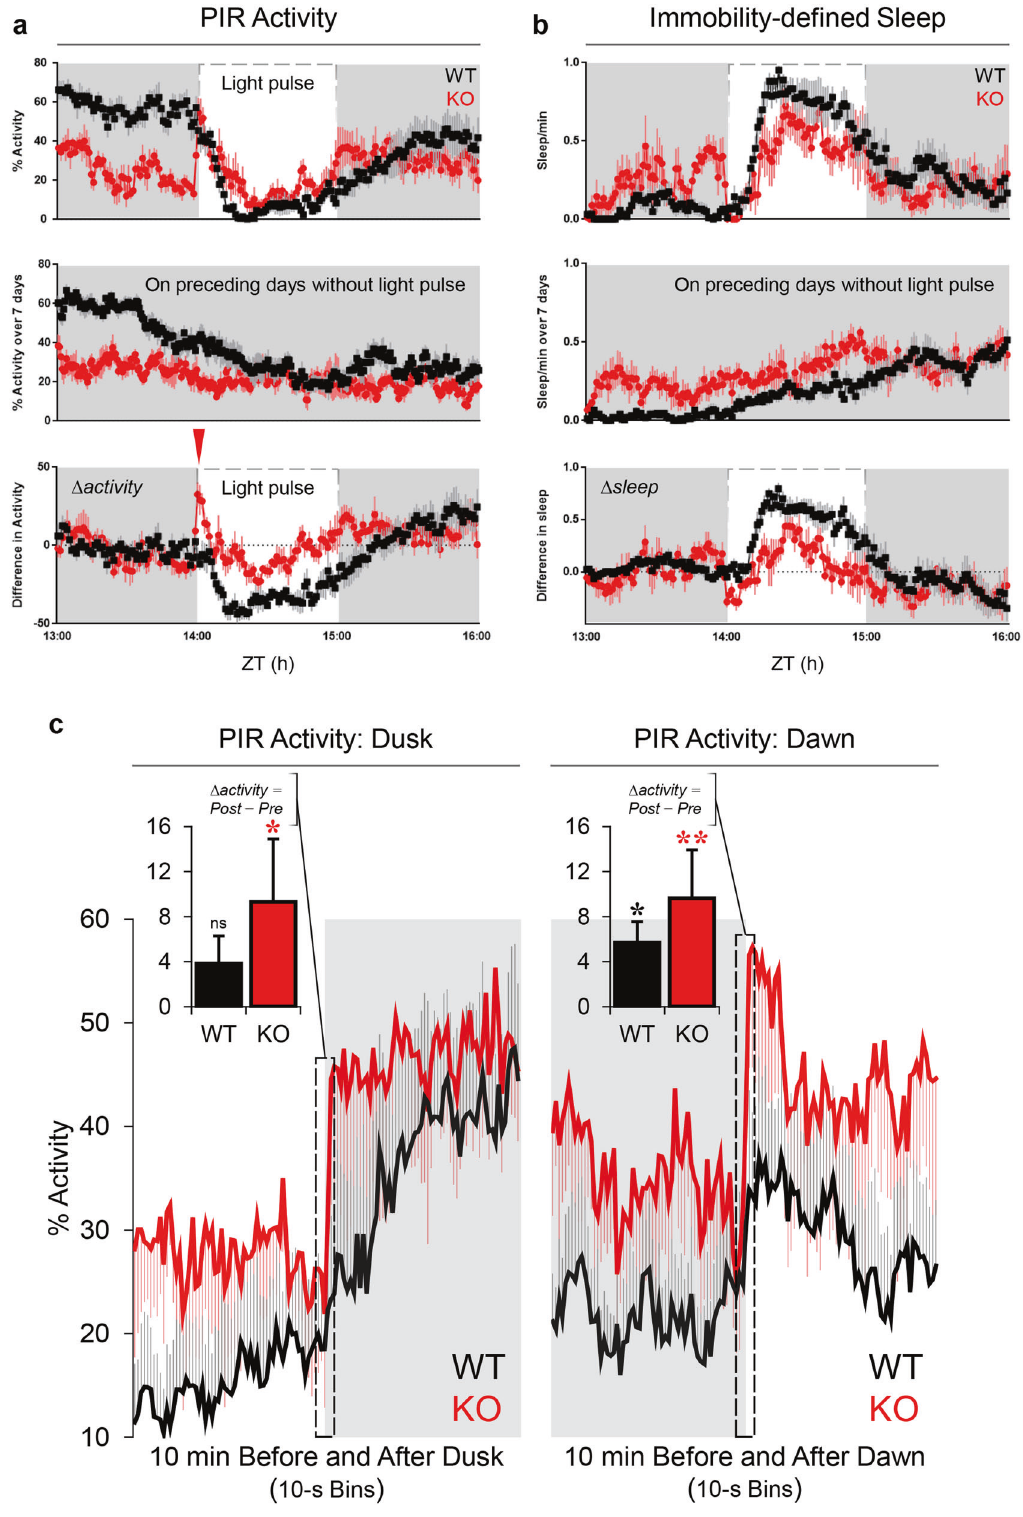
Δ activity in the 10 s after light/dark transitions was nearly doubled in knockouts (wild-types vs. GluA1 knockouts = + 4.77 ± 1.34% vs. + 9.46 ± 1.33%). Thus, GluA1-knockout mice exhibited increased sensitivity to lighting